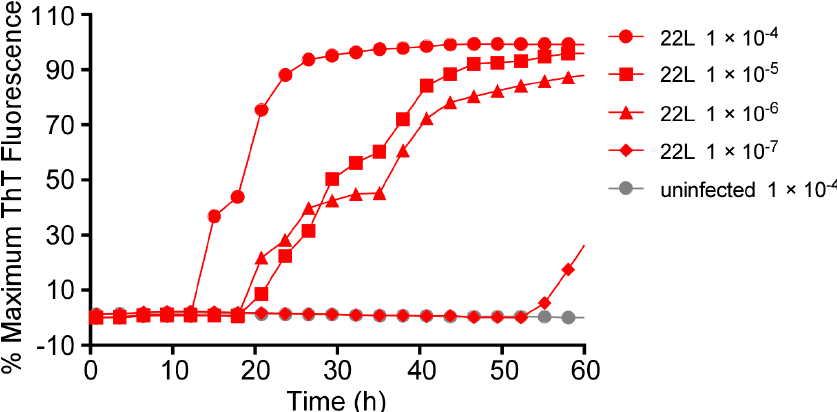
Figure 9. Sensitivity of the RT-QuIC for the detection of 22L prion seeding activity in the presence of 0.001% SDS. Brain homogenate from a 22L prion strain infected (red) and an uninfected (gray) mouse were serially diluted in 0.1% SDS/PBS/N2 solution. The final indicated dilutions were prepared to give a final SDS concentration per reaction of 0.001%. The substrate was Mouse rPrP Sen (23–231) in combination with 130 mM NaCl. The average normalized fluorescence from replicate wells is plotted as a function of time. Although ThT readings were taken every 45 min, for visual clarity, the curves report only readings at 135-min intervals.